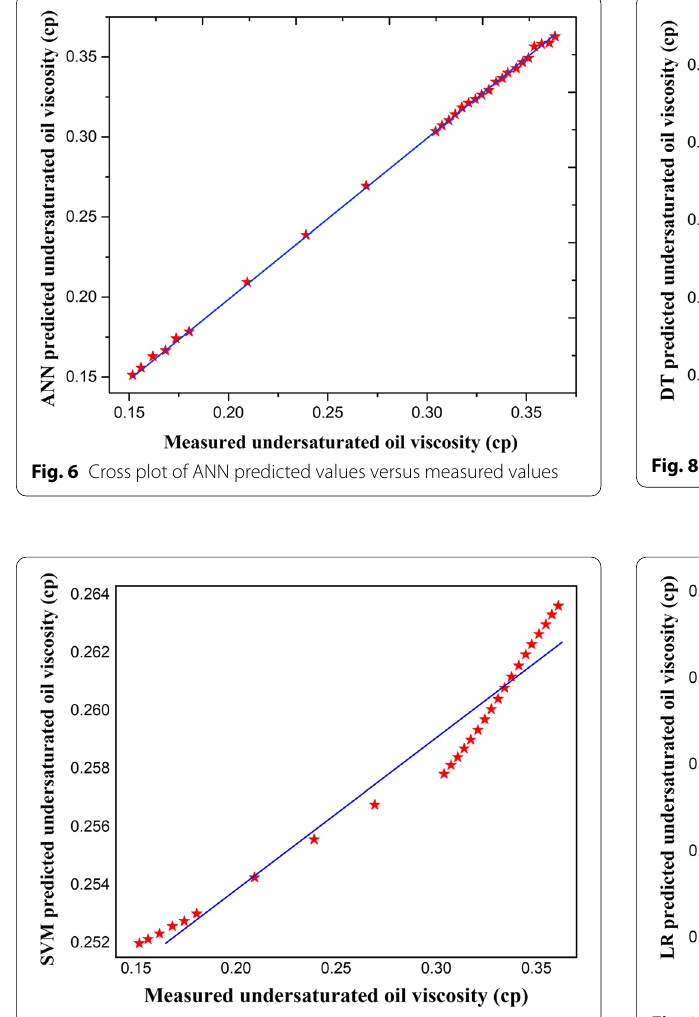
Fig. 7 Cross plot of SVM predicted values versus measured values